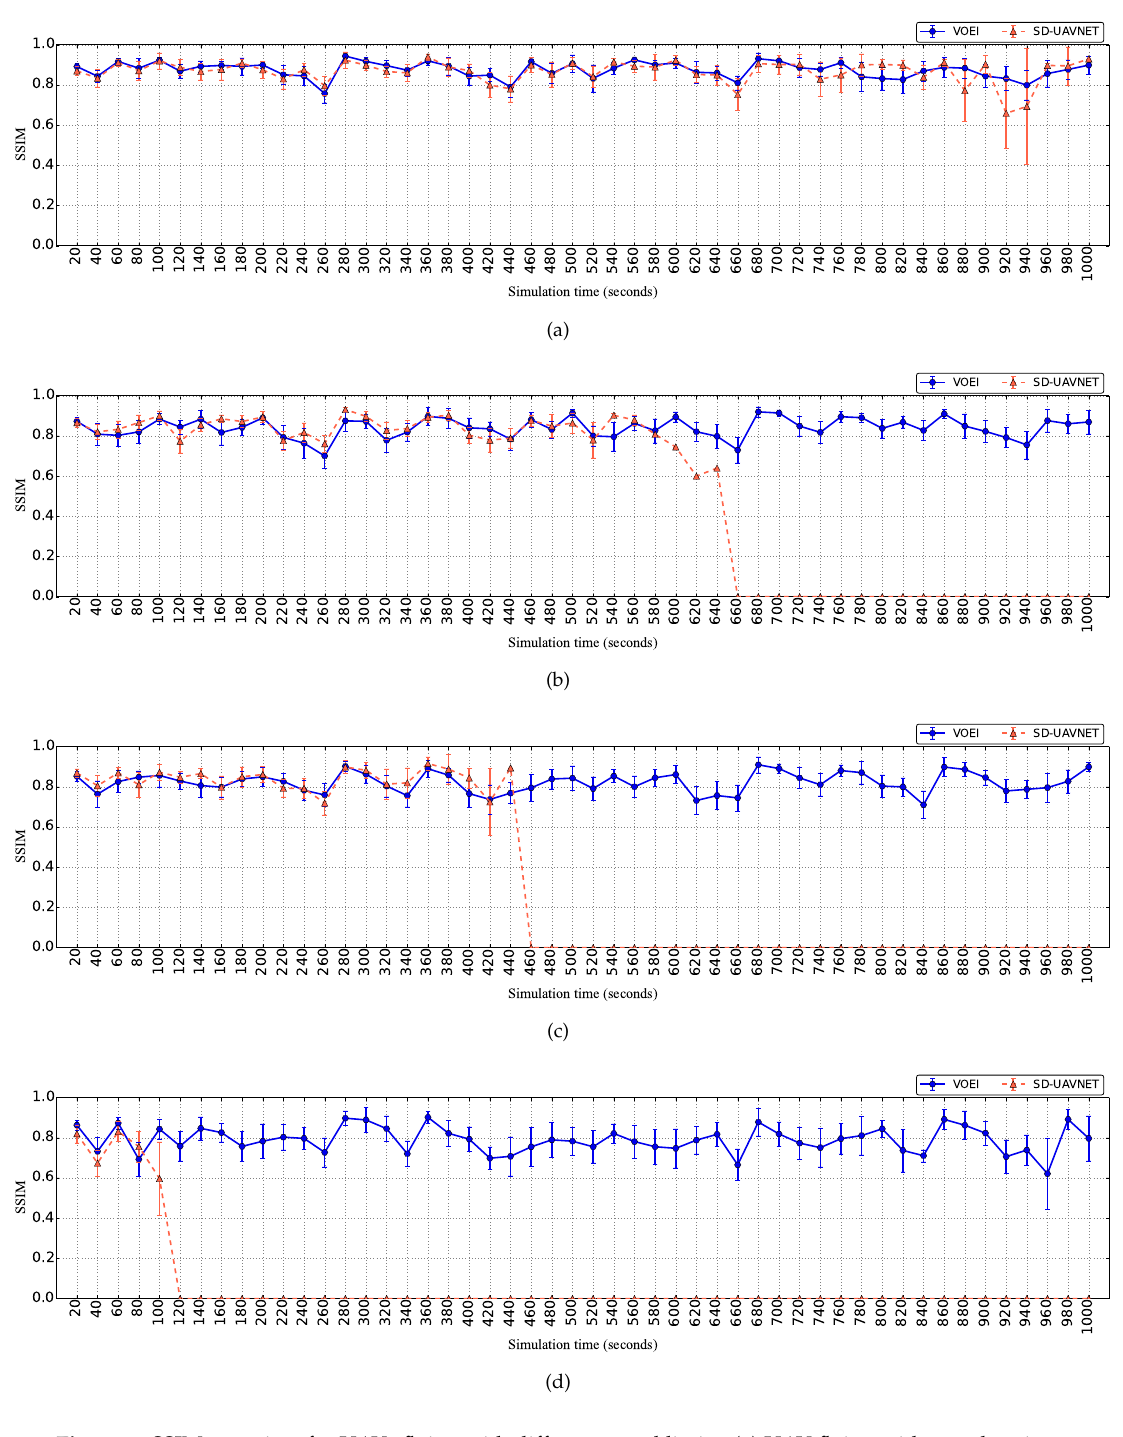
Figure 6. SSIM over time for UAVs flying with different speed limits. ( a ) UAV flying with speed raging from 1 to 5 m/s; ( b ) UAV flying with speed raging from 5 to 10 m/s; ( c ) UAV flying with speed raging from 10 to 15 m/s; ( d ) UAV flying with speed raging from 15 to 20